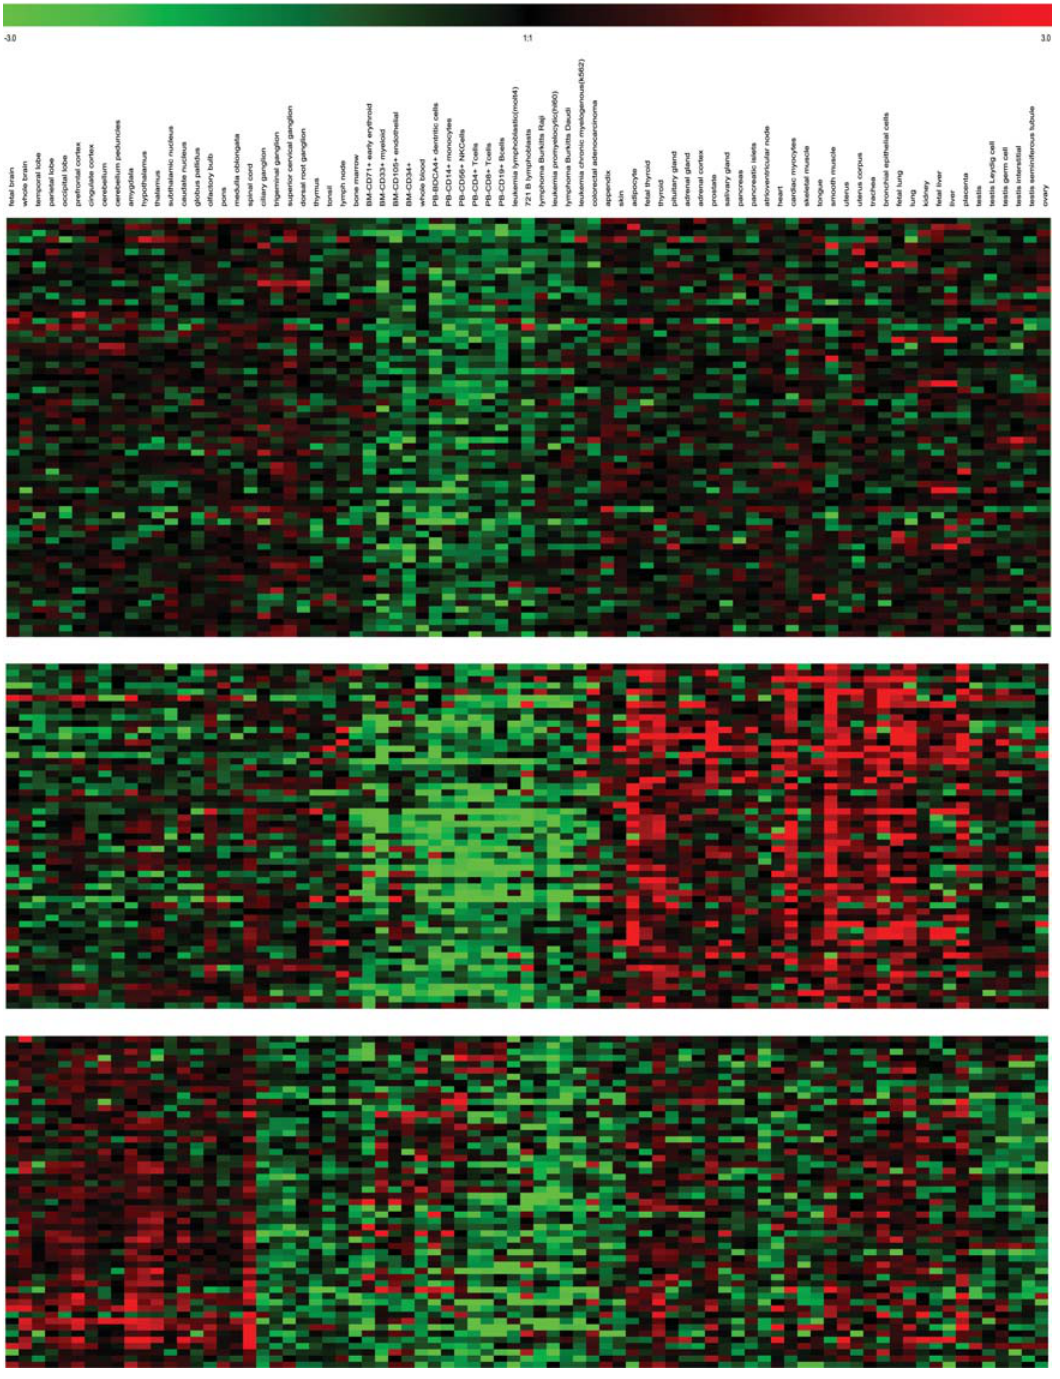
Figure 7. Representative gene expression profiles for putative hsa-mir-548 target genes from three coexpressed clusters (12, 15 and 20 in Figure 6). Expression profiles are median centered and log 2 normalized, and the log 2 ratio color scale is shown above the plot. Overexpressed genes are shown in red and underexpressed genes are shown in green.